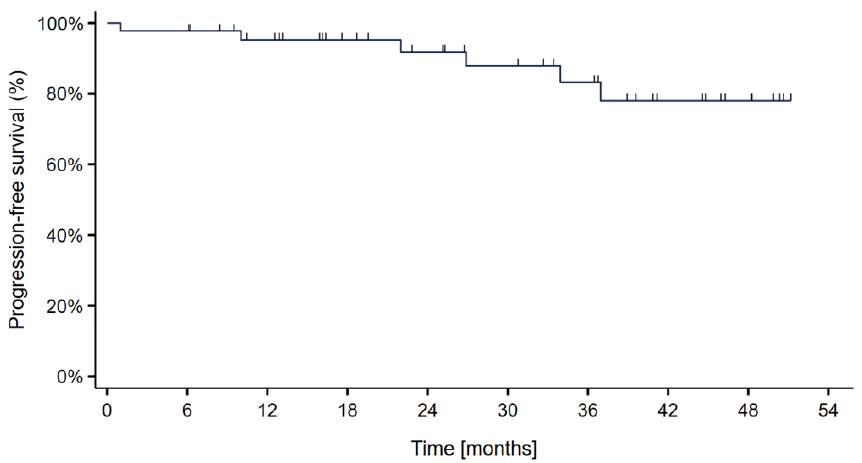
Figure 4. Kaplan – Meier curve showing the progression-free survival probability in 44 skull-base Figure 4. Kaplan–Meier curve showing the progression-free survival probability in 44 skull-base chordoma patients treated with particle therapy at MedAustron. chordoma patients treated with particle therapy at